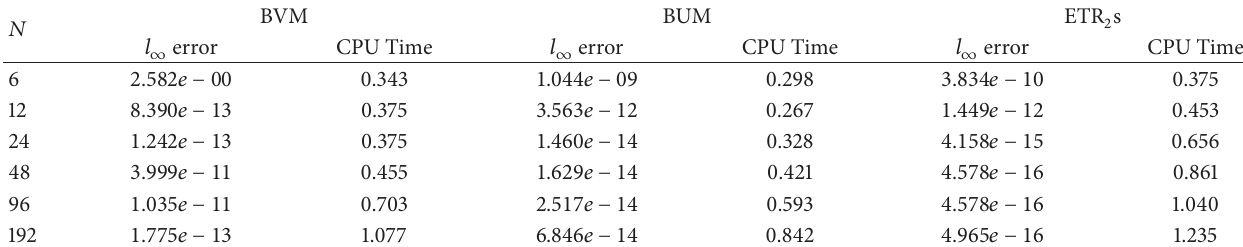
Table 8: Computational results for V = 3 for Example